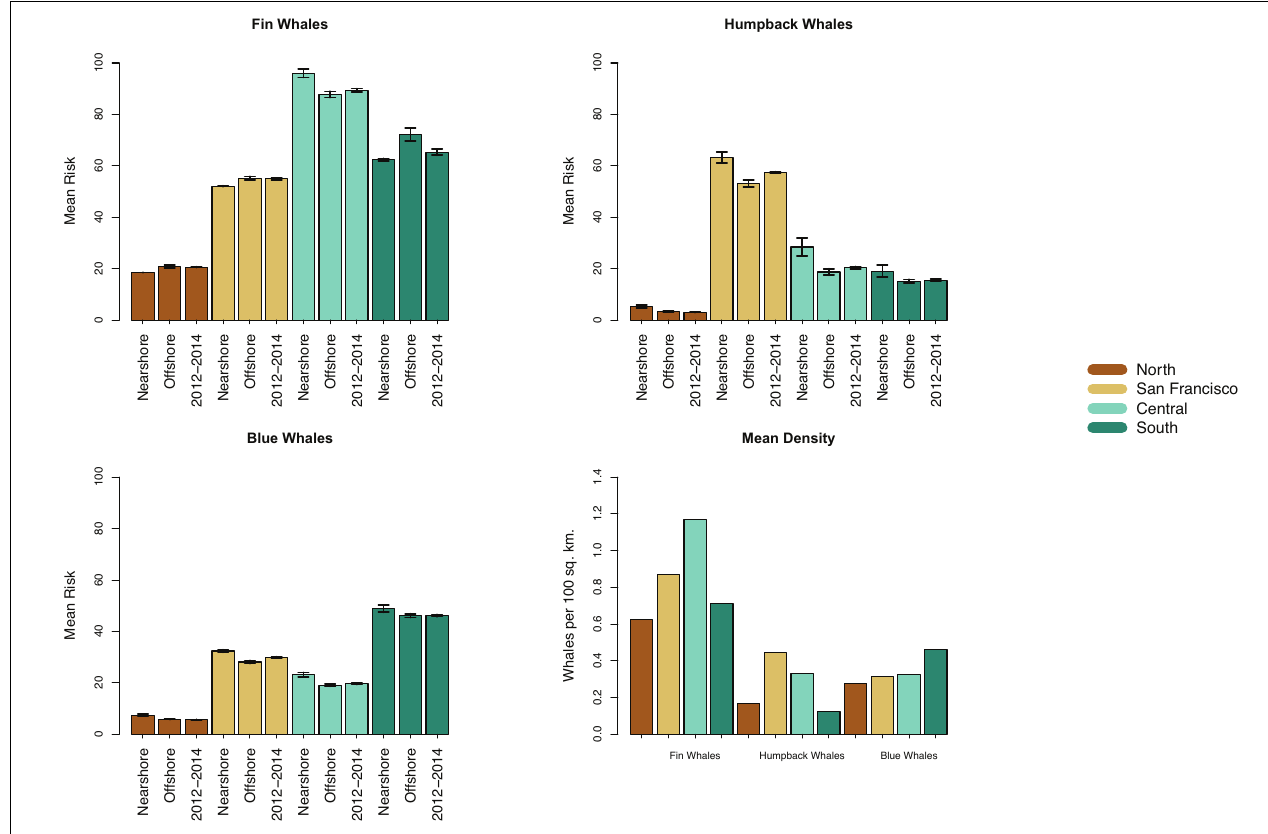
FIGURE 3 | The scenarios associated with the 2008–2015 ship traffic (i.e., nearshore or offshore; 2012–2014 was classified as nearshore or offshore on region-by-region basis) were defined using a boundary that was 24 nmi from the mainland coast (see text for details). The ship traffic scenarios influenced ship-strike risk (predicted number of whales multiplied by the km/day traveled by ships) for fin, humpback, and blue whales in each region. The risk shown here was calculated using the mean predicted whale distributions. The standard error of the mean risk was calculated using the years of ship traffic data in each scenario. The mean predicted whale density (whales per 100 km 2 ) in each region is also